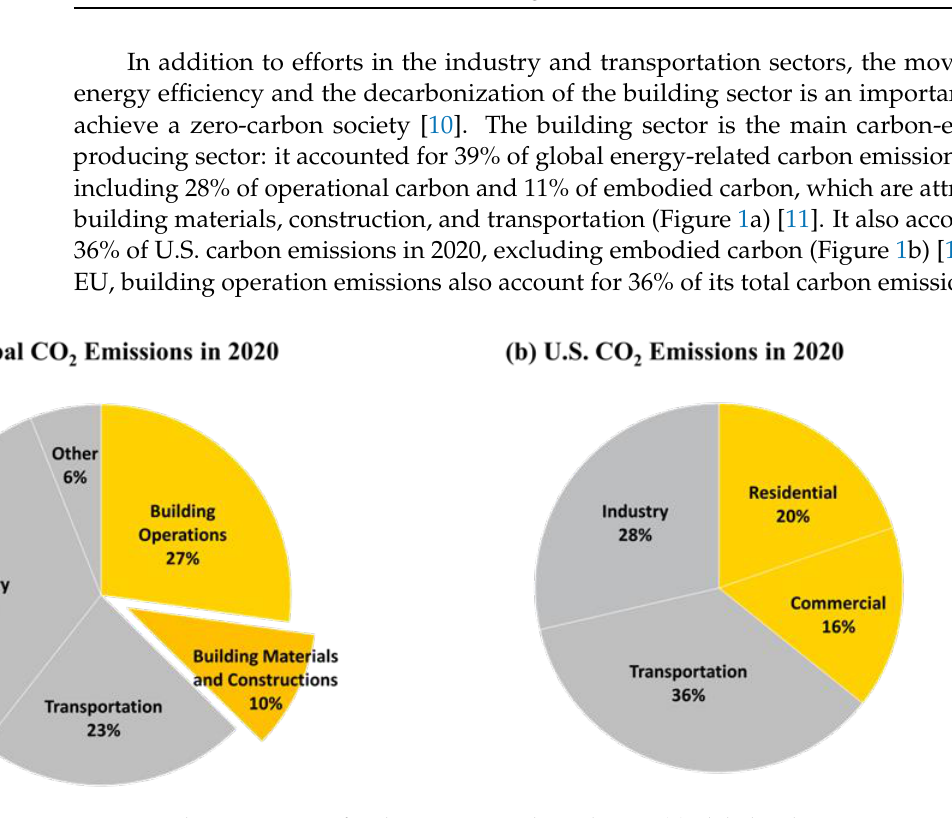
Figure 1. The proportion of carbon emissions by industry: ( a ) global carbon emissions in 2020 [11]; ( b ) U.S. carbon emissions in 2020 (data from the U.S. Energy Information Center [12].